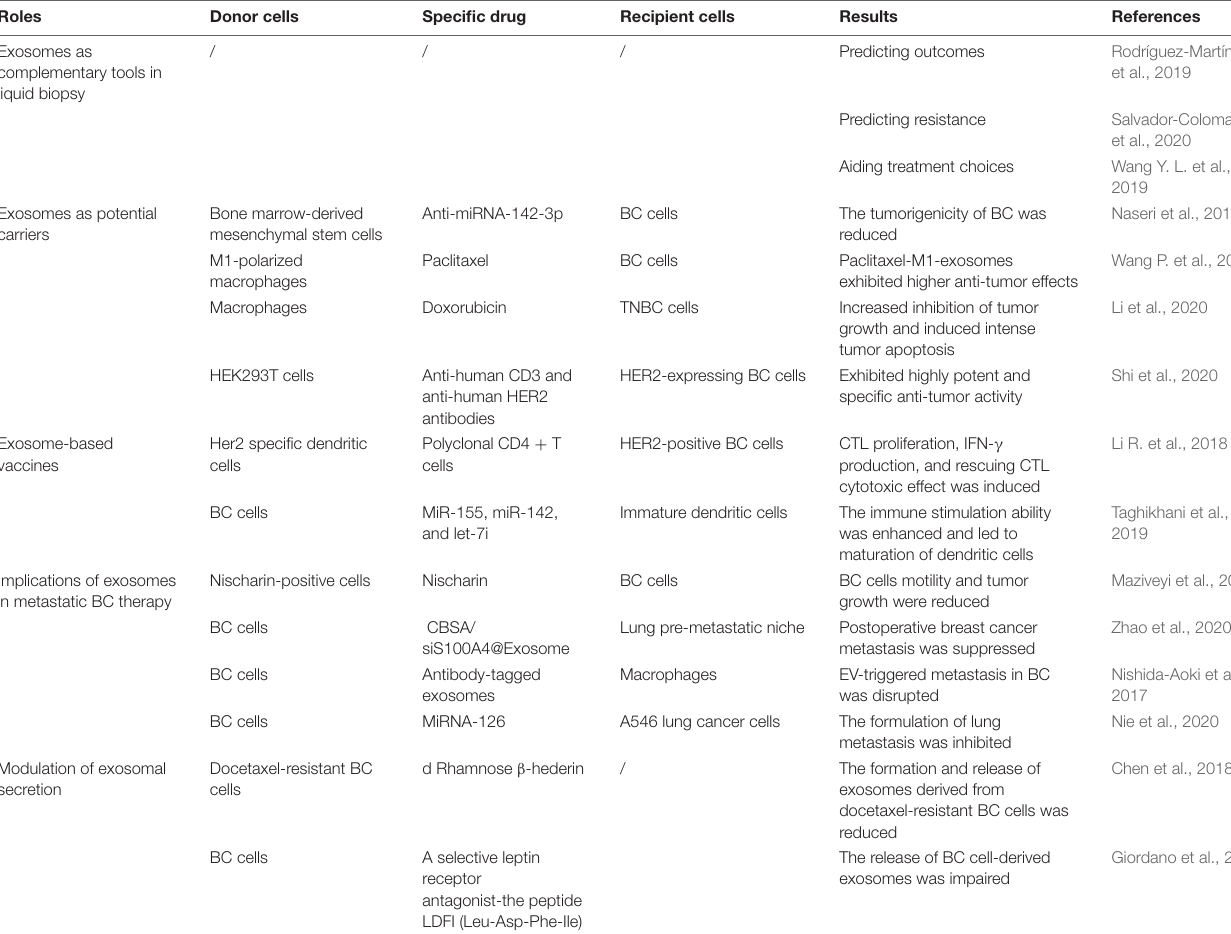
TABLE 2 | The potential roles of exosomes in treating